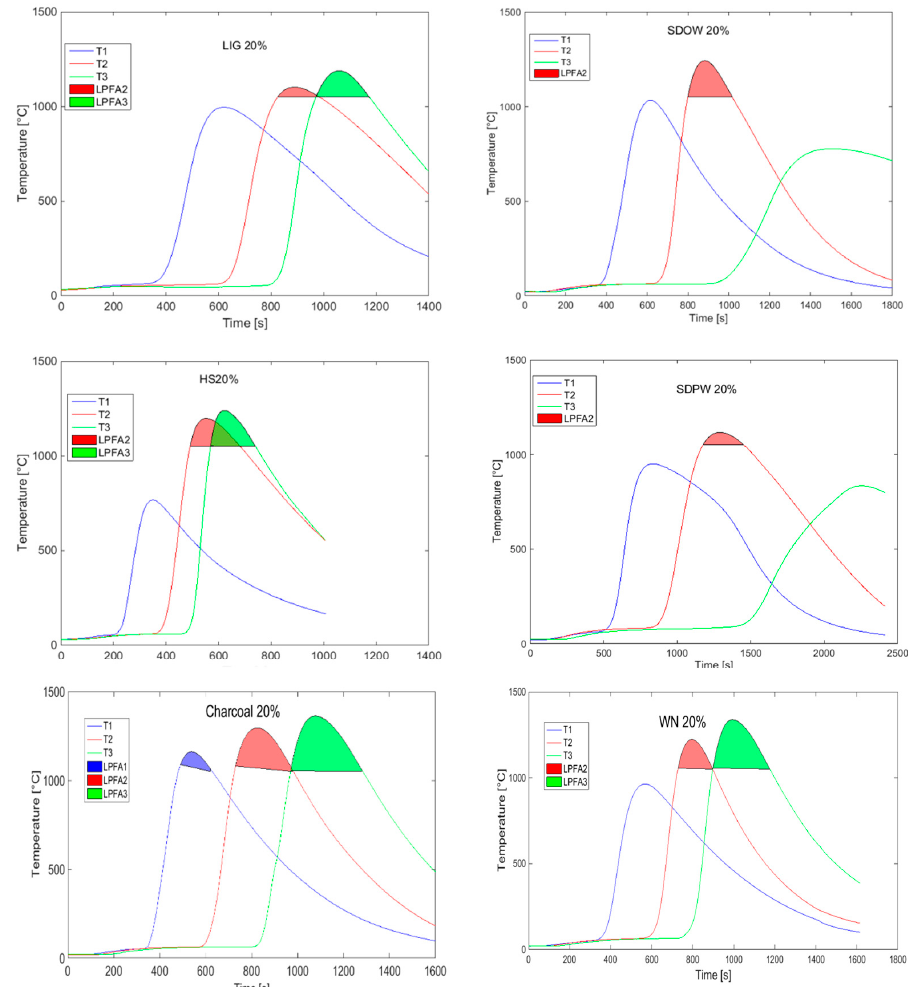
Figure 11. Temperature curves for 20% coke substitution with biomass. (WN: walnut shells, Charcoal, Lig: lignin, SDOW: saw dust from oak wood, SDPQ: saw dust from pine wood, HS: hemp shoves.).